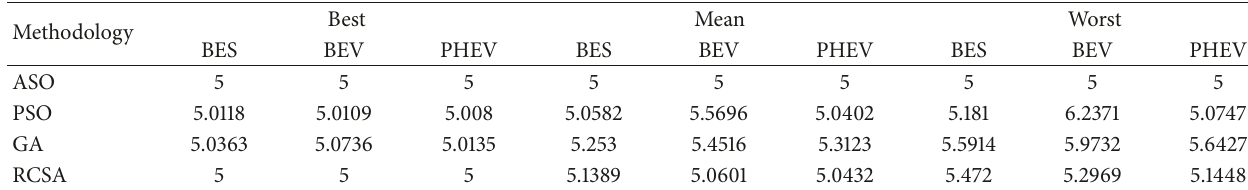
Table 11: Optimized capacities of batteries in Case